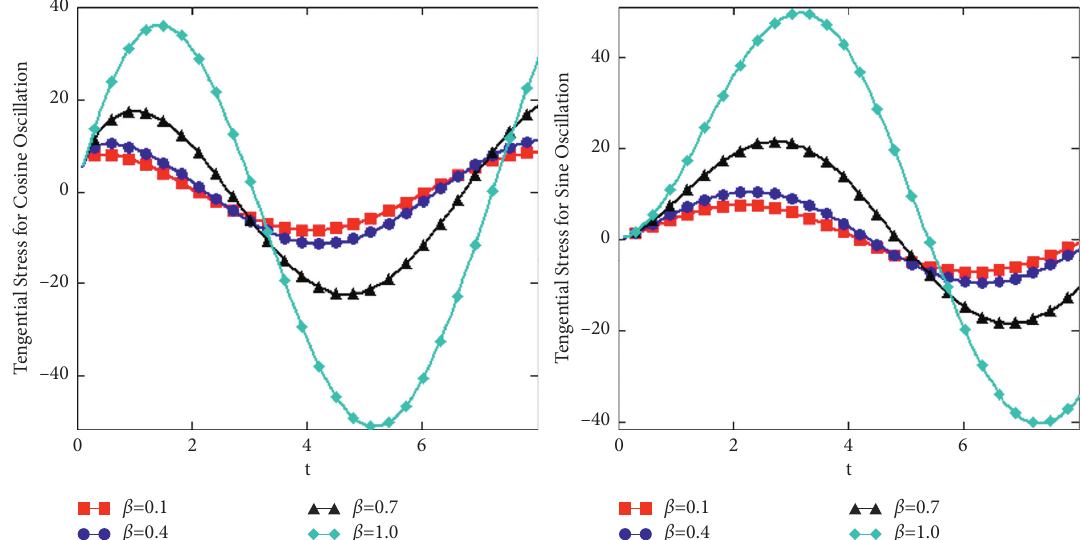
Figure 9: The variation of β for both the oscillations with ω � π /4, λ